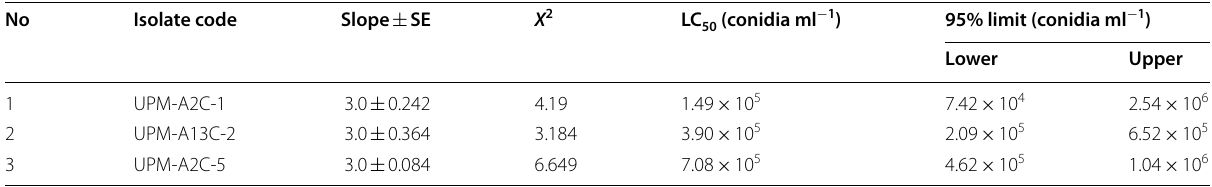
) of Group 1 EPF isolates against Coptotermes 50